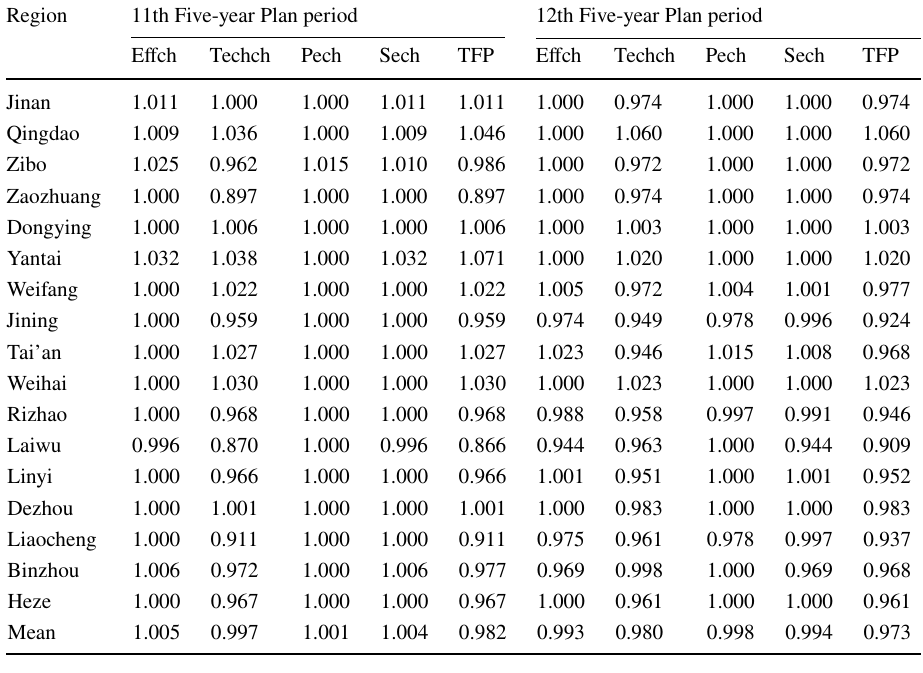
Fig. 3 Comparison diagram of TFP index summary between 11th and 12th Five-year Plan